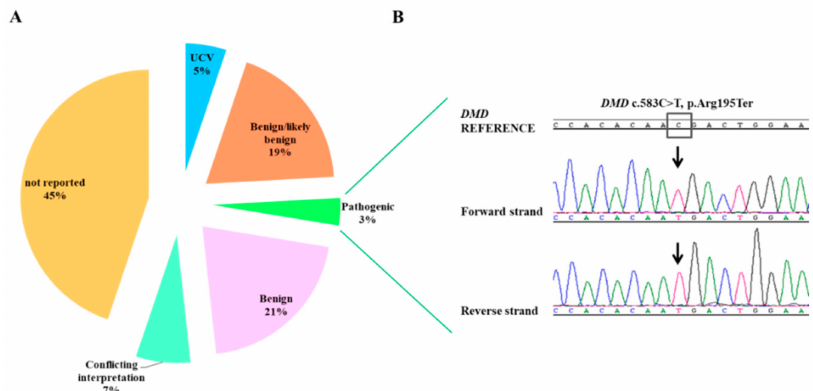
Figure 2. Single nucleotide variants (SNVs) identified in the study group. ( A ) Pie chart illustrating the distribution (%) of the SNVs detected by NGS and classified according to their clinical significance by ClinVar Database; 3% of them corresponds to pathogenic mutations. ( B ) The c.583C>T (p.Arg195*) hemizygous mutation was found in one male subject by NGS and confirmed by Sanger sequencing as shown in the electropherogram assembled with the reference sequence ENST00000357033.8 (NM_000109; NP_000100). The figure highlights the presence of the variant in the forward and reverse strand respectively, as indicated by the arrows. DMD, Duchenne muscular dystrophy; NGS, next generation sequencing; UCV, uncertain significance